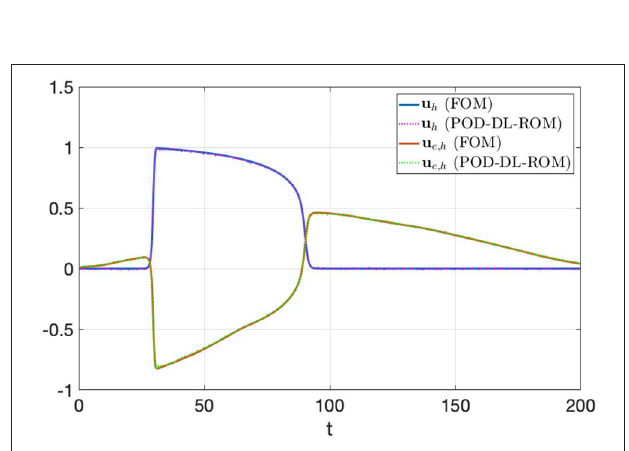
FIGURE 6 | Test 1.2 : FOM and POD-DL-ROM, with n = 2 and N = 256, APs for the testing-parameter instance µ test = 0.0295 (cid:127) − 1 cm − 1